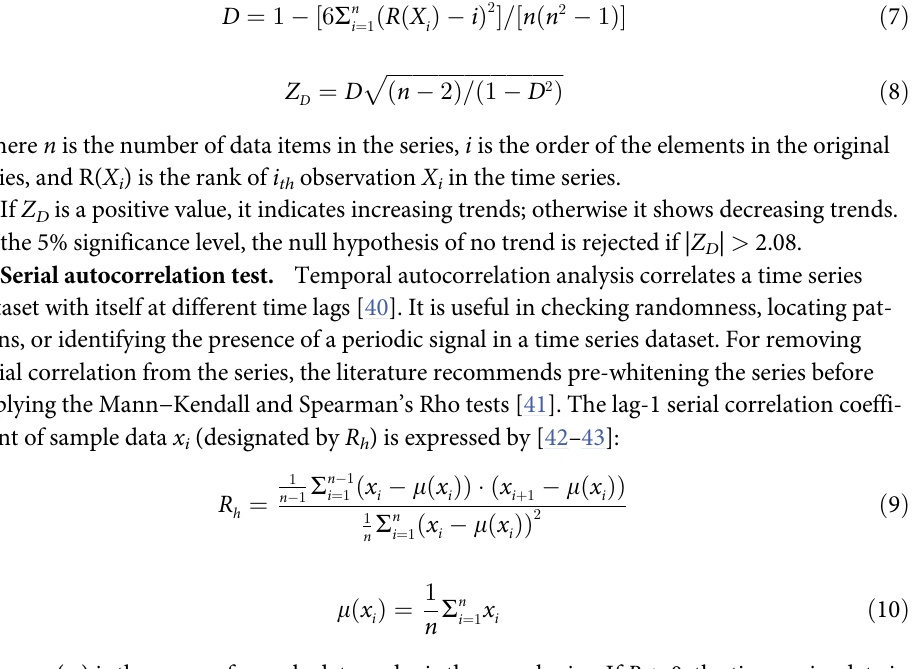
Where n is the sample size.